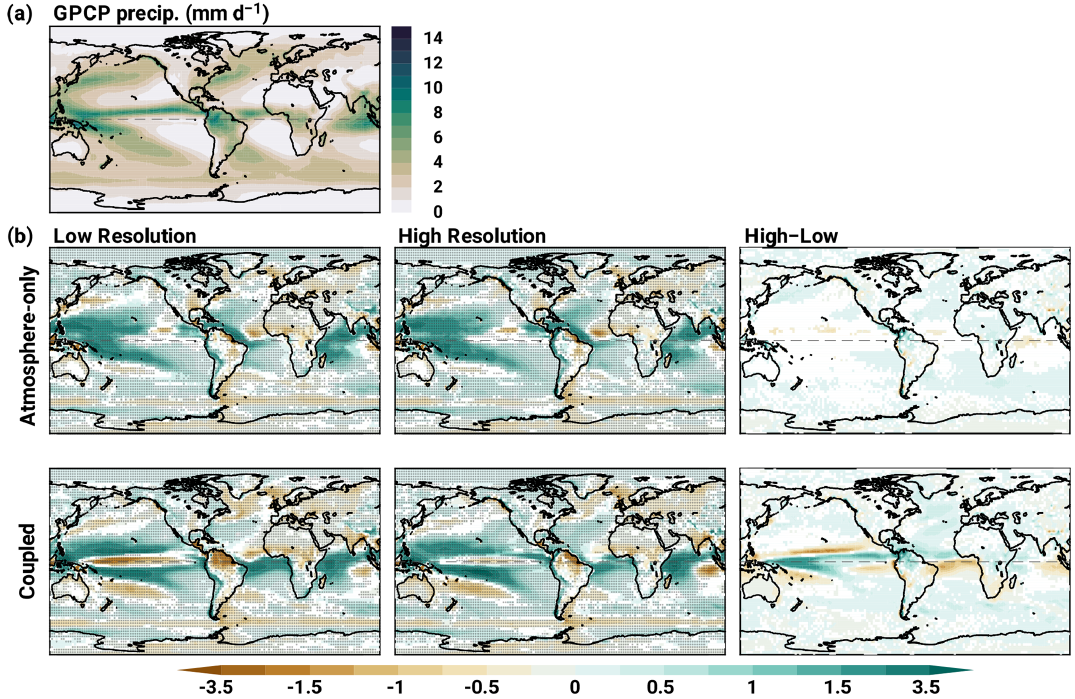
Figure 2. (a) GPCP precipitation rate (in mmd − 1 ). (b) Multi-model ensemble mean bias in precipitation rate (in mmd − 1 ) with respect to the GPCP precipitation at low and high resolution (left and middle) and differences between the two resolutions (right), as in Fig.